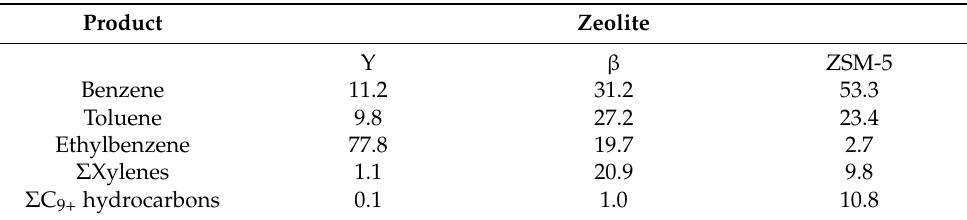
Table 8. The product of the PS depolymerization in HCO over various